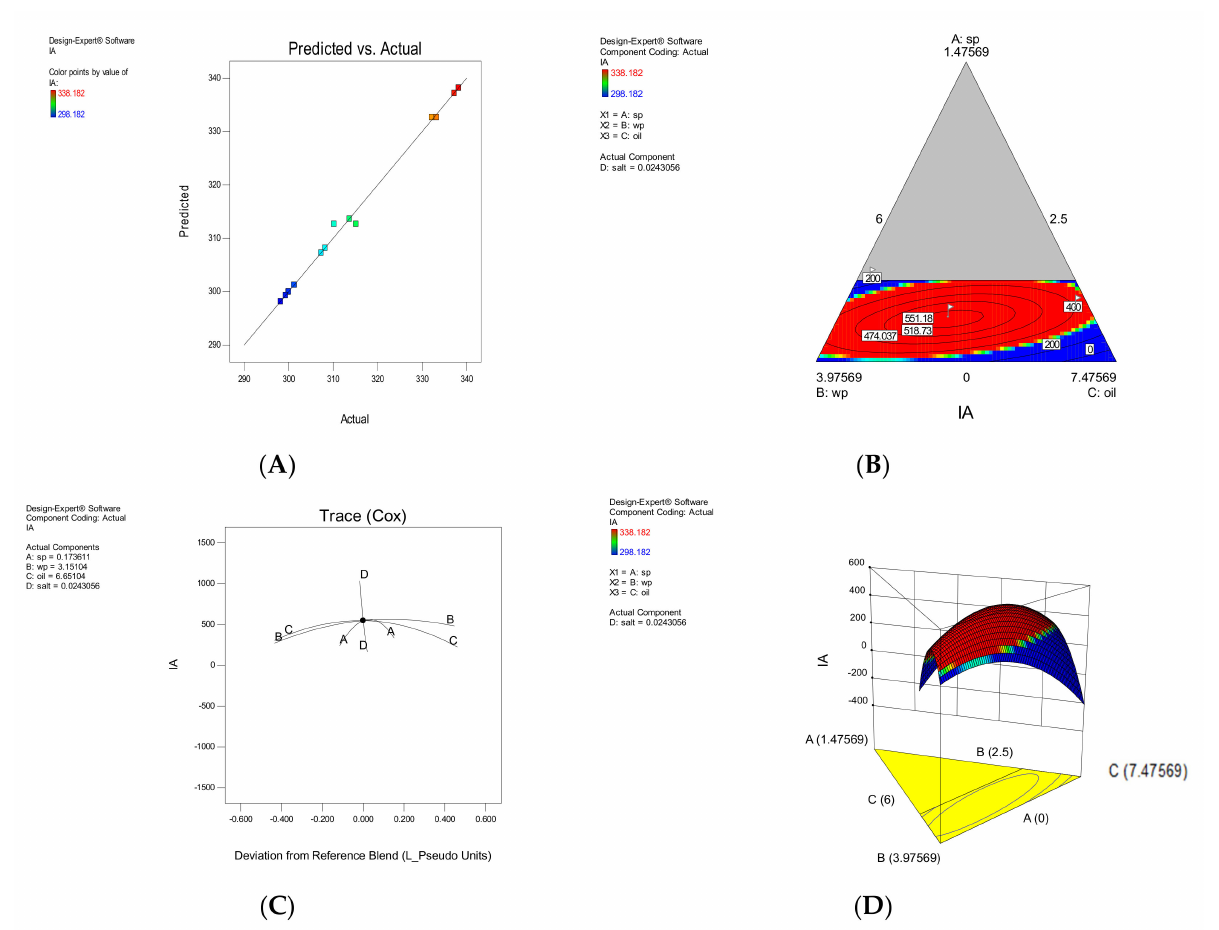
Figure 3. The effect of each parameter on index of acceptability (AI). The correlation between experimental and approximated values ( A ), Contour plot ( B ), Trace plot ( C ), three-dimensional response surface plot ( D ).